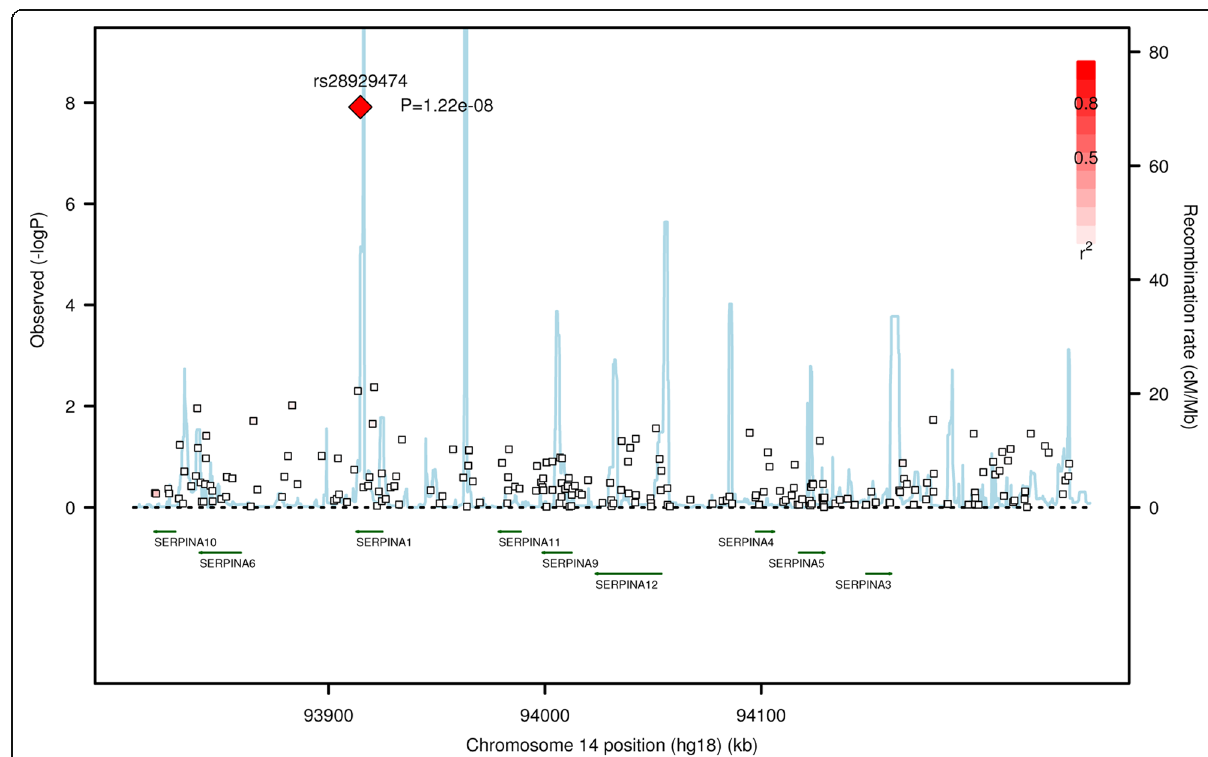
Fig. 1 Association plot of SERPINA1 region with post-bronchodilator FEV 1 /FVC. Negative logarithm-transformed P value ( left ) and recombination rate ( right ). Red color scale represents the strength of linkage disequilibrium of SNPs with